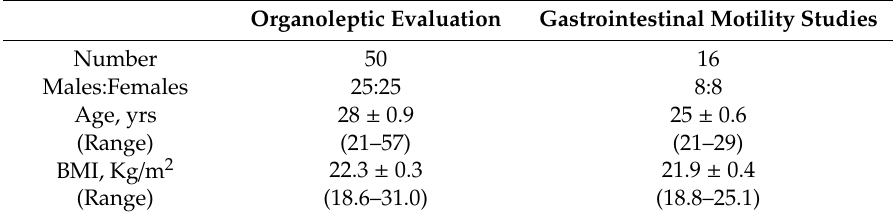
Table 1. Clinical characteristics of enrolled